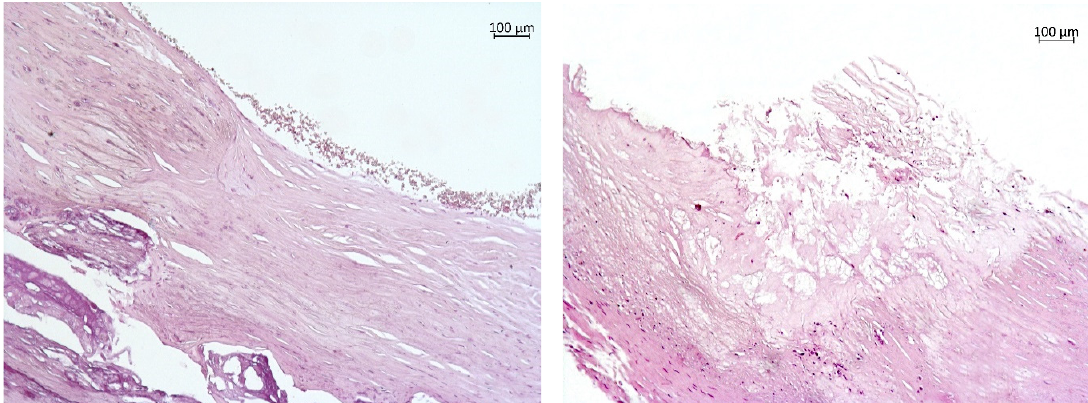
Figure 2. Atherosclerotic plaques with various degrees of calcification. ( a ) Without calcification